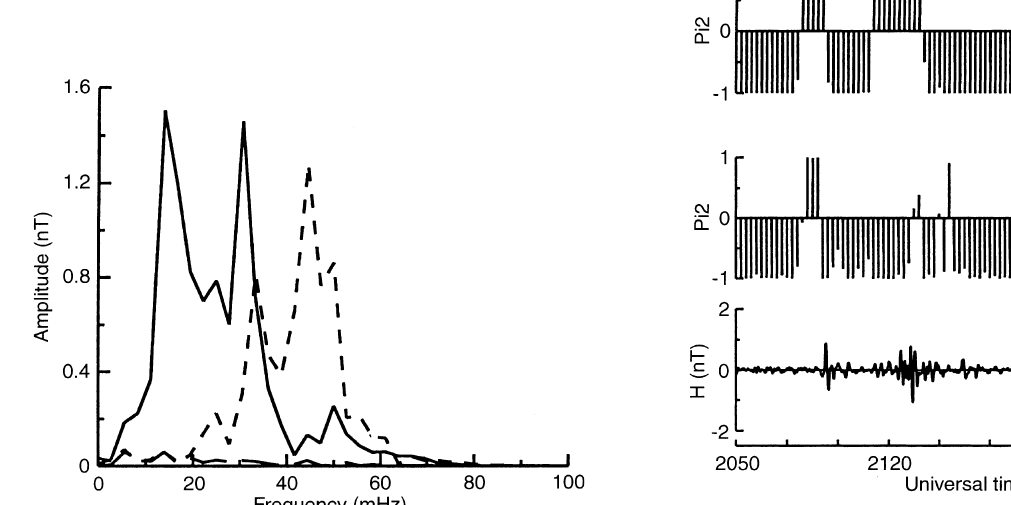
Fig. 4. Examples of the output from the ANN when a section of data containing Pi2 signatures ( lower ) is scanned. The outputs at centre and upper are those obtained when the time-series itself and the amplitude spectrum of the time-series, respectively,